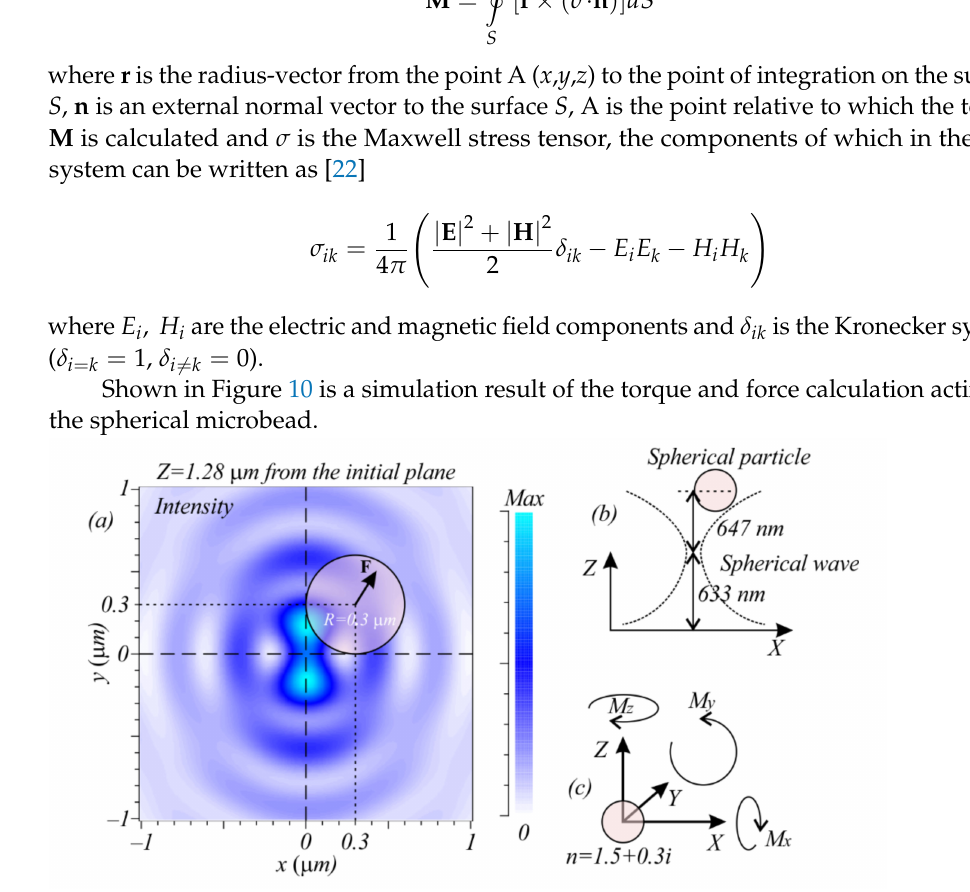
Figure 10. Intensity pattern ( a ) and a spherical bead with radius R = 0.3 µ m. The position of the bead is X p = 0.3 µ m, Y p = 0.3 µ m. Shown at the right are a schematic position of the bead ( b ) and directions of the positive torques values along the x , y and z axis ( c